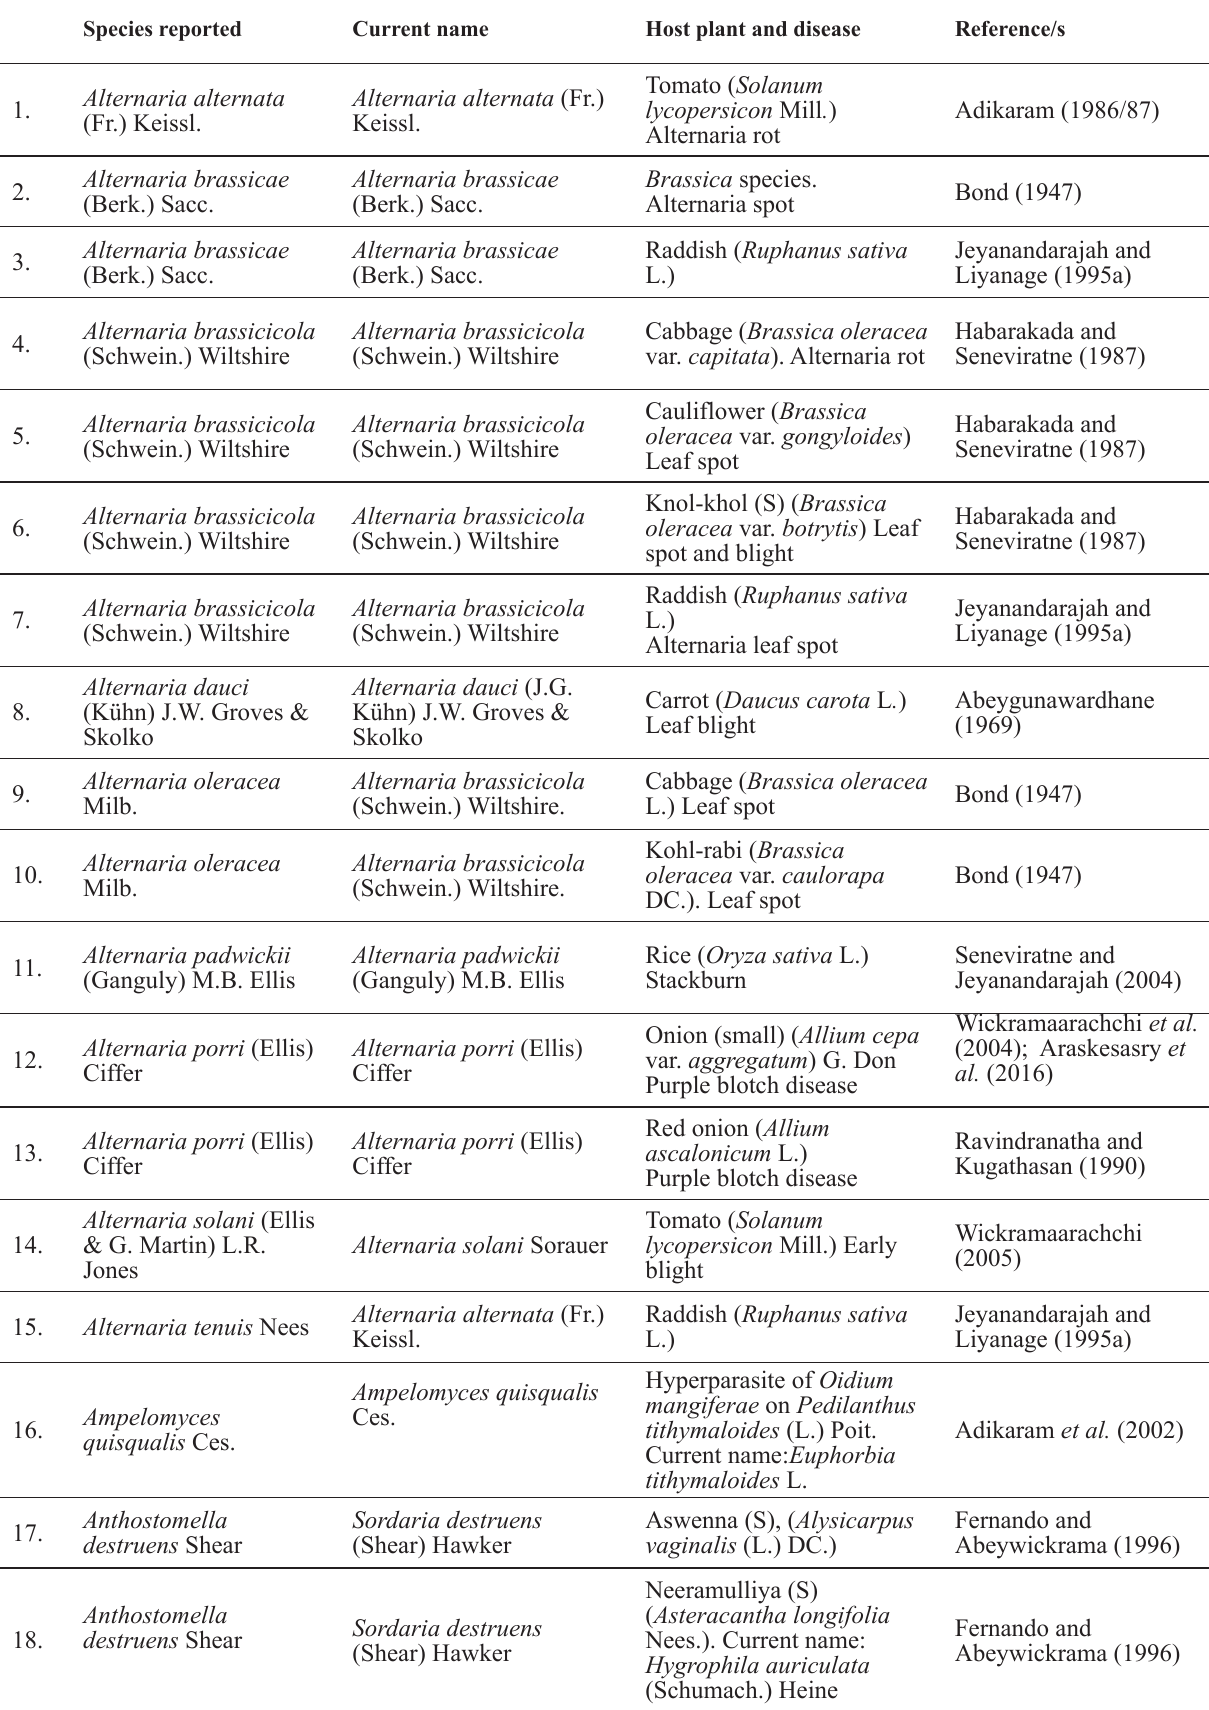
Table 1: Checklist of Plant Pathogenic fungi and Oomycota in Sri Lanka. Species